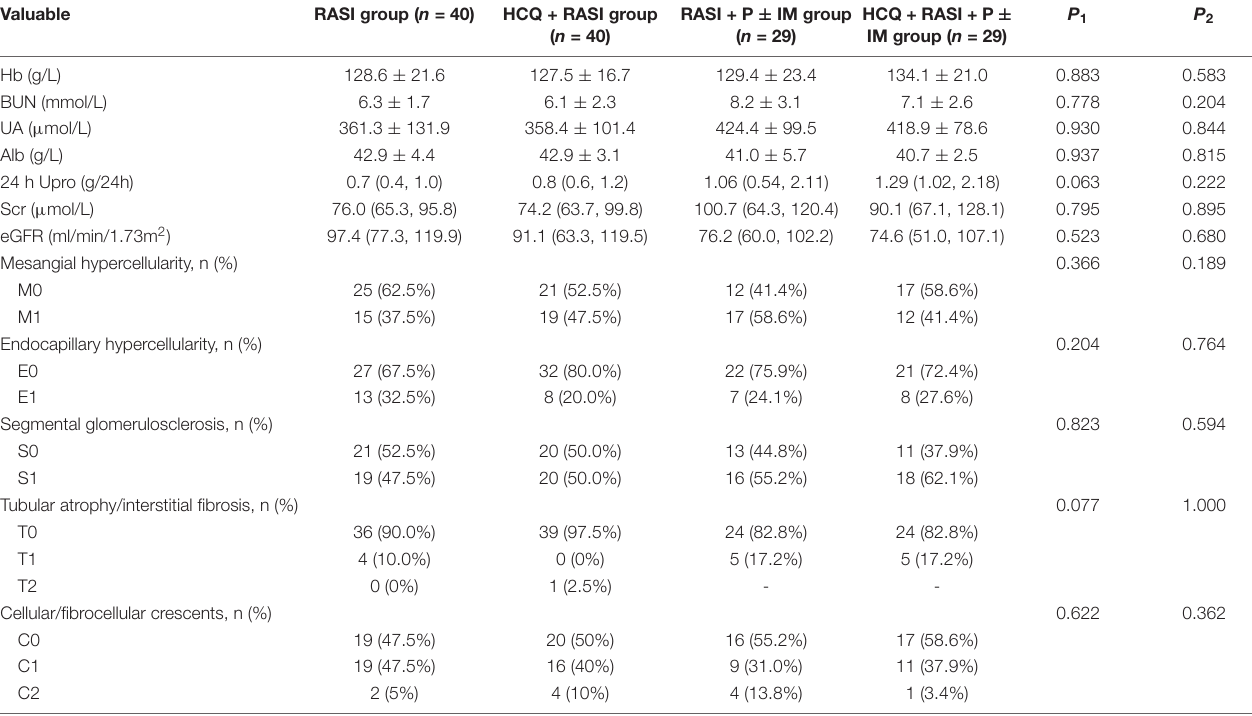
TABLE 3 | The clinicopathological characteristics of IgAN patients at the time of enrollment after matching. Valuable